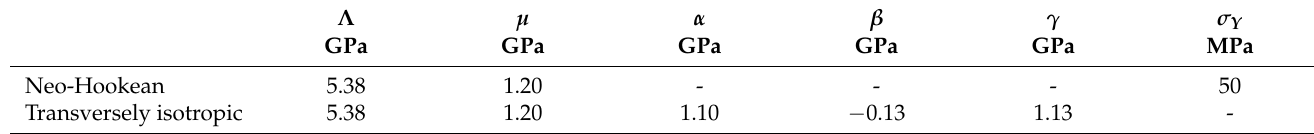
Table 6. Material parameters validation with neo-Hookean material model.